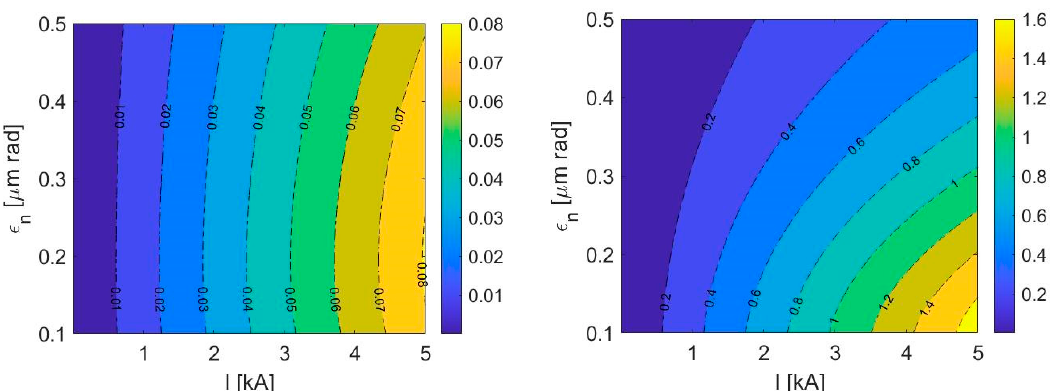
Figure 8. FEL peak brilliance (Equation (13)) with 3-D corrections, as function of the beam normalized slice emittance and peak current at the undulator, in units of 10 33 #photons/sec/mm 2 /mrad 2 /0.1%bw, at the photon energy of 2 keV (left) and 16 keV (right). The electron beam energy is, respectively, 2 and 5.5 GeV.